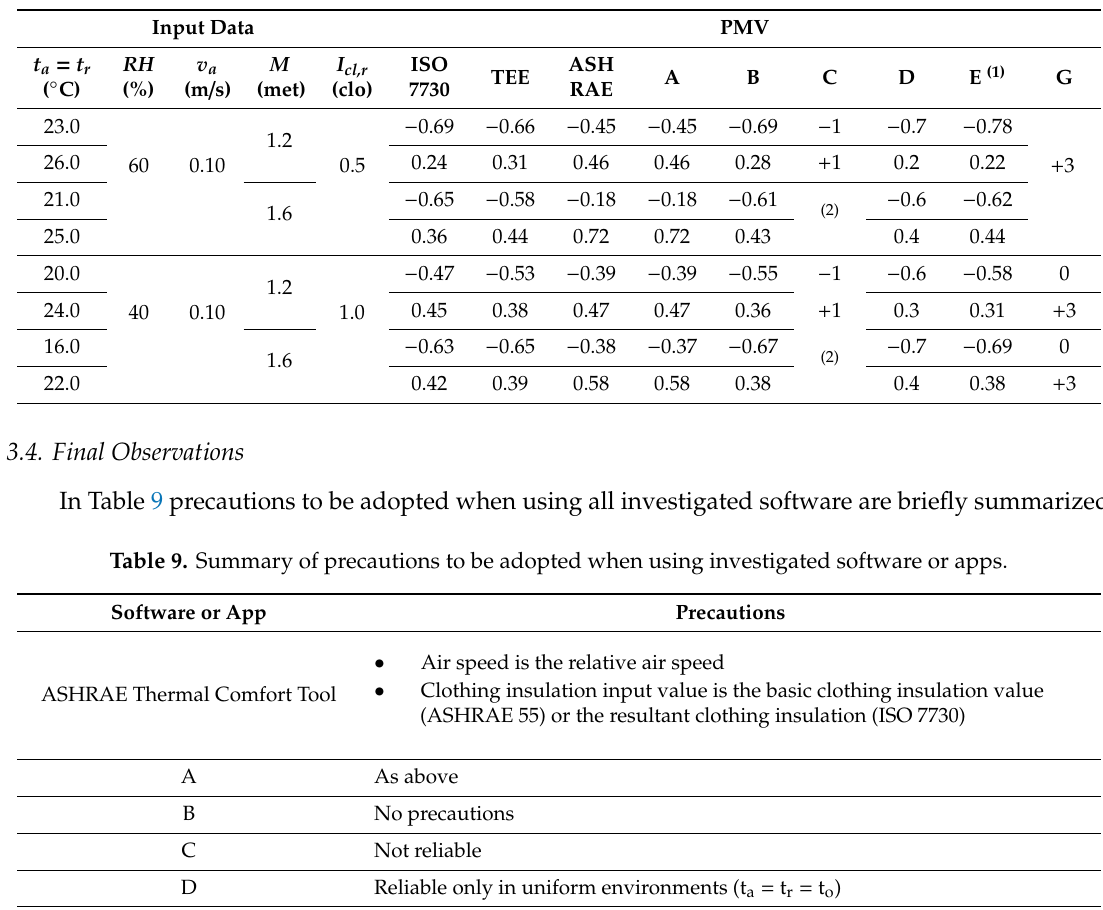
Table 8. PMV values and comfort categories calculated with the investigated software and comparison with values from ISO 7730 tables. Relative velocity has been calculated according to Equation (2). (1) PMV value has been calculated by means of Equation (4). (2) It is not allowed changing the metabolic rate